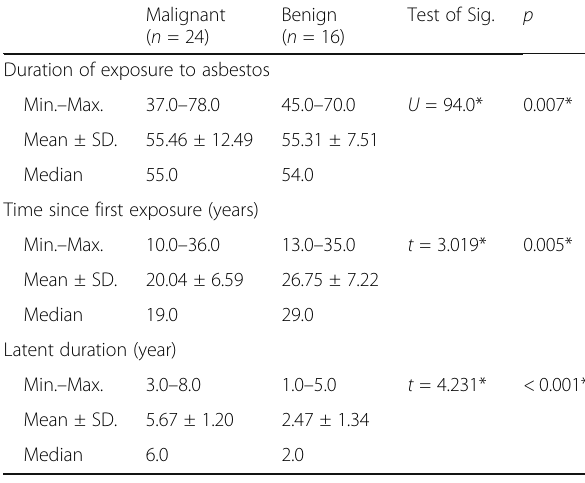
Table 2 Comparison between the two studied groups according to duration of different parameters Malignant Benign Test of Sig. p ( n = 24) ( n = 16)